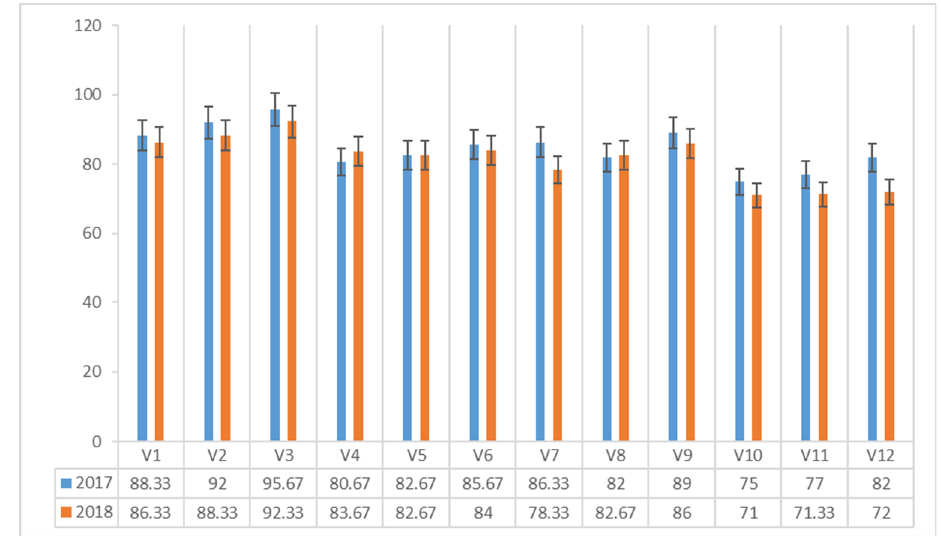
Figure 1. Ergosterol content of Agaricus blazei Murrill mushrooms (mg 100g −1 dm) in two years of experiments.